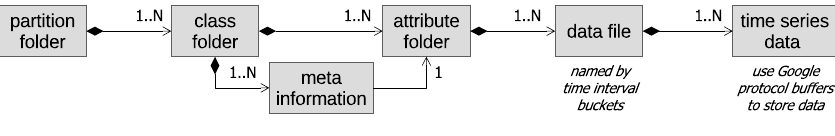
Figure 2. The PBEAST data organization.